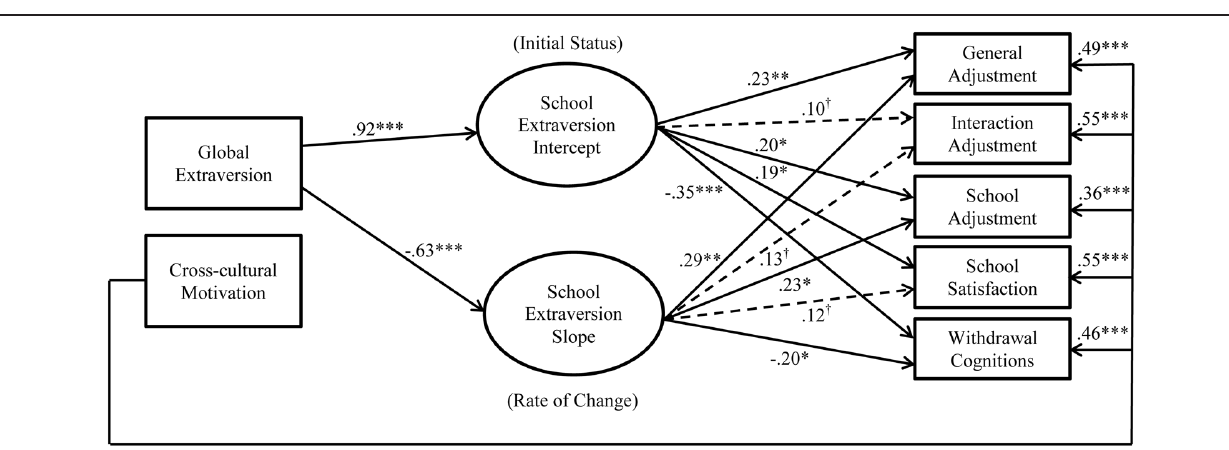
adjustment, β = 0.14, p = 0.06. Based on these results, we